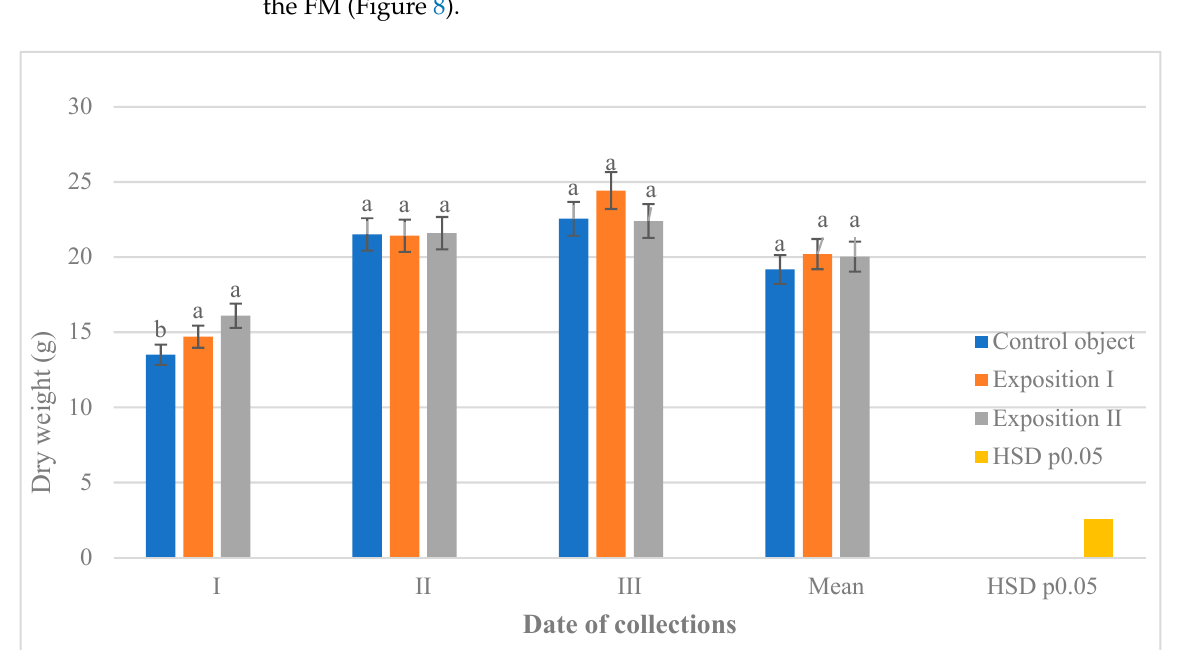
11 of 21 Figure 7. The effect of seed stimulation and harvest time on the mass of the 5th leaf (g) (2015–2017). * I—20 days after sowing, II—40 days after sowing, and III—60 days after sowing; control object— the seeds without stimulation with FM, exposition I—the seeds were stimulated with FM for 15 s, and exposition II—the seeds were stimulated with FM for 30 s.; Letter indicators (a, b, c, etc.) next to averages refer to the so-called homogeneous (statistically homogeneous) groups. The occurrence of the same letter indicator next to the means (at least one) means that there are no statistically significant differences at p 0.05 between them. A significant increase in the weight of the fifth leaf compared with the control object occurred only in the objects with a shorter FM exposure time. The increase in the fresh weight of the fifth leaf depended on the date of its collection. In the first term of the col- lection of leaves, 28 days after sowing, there was an increase in this feature due to the stimulation of the seeds with the FM only in the conditions of the prolonged effects of this treatment compared to the control object. Additionally, the difference between a shorter and longer duration of exposure to the FM turned out to be irrelevant. In the second term of the collection of leaves, a significant increase in the weight of the leaf was only found in the object with a shorter exposure of the seed to the FM compared with the control